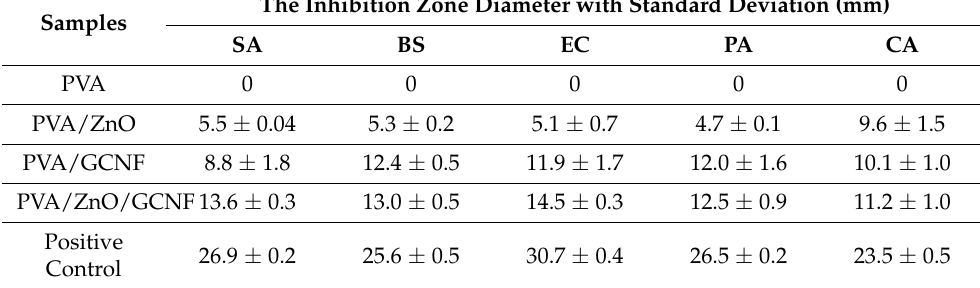
Table 4. Antimicrobial properties of each sample.